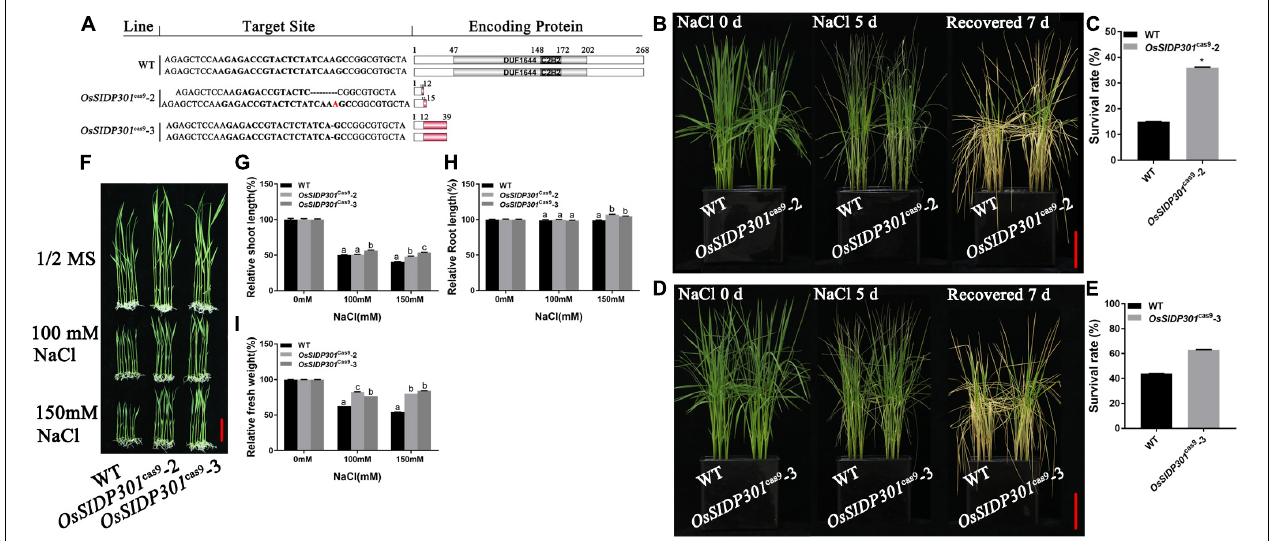
FIGURE 4 | Mutants of OsSIDP301 were conferred salt tolerance. (A) Mutation types of OsSIDP301 mutants. (B–E) Phenotype and survival rate of mutants were treated with containing 150 mM NaCl solution for 5 days and then recovered for 7 days, bar = 4 cm. (F) Phenotypes of mutants with NaCl treatment at the seedling stage, bar = 2 cm. Comparisons of shoot length (G) , root length (H) , fresh weight (I) between WT and mutants with or without NaCl treatment for 7 days. Data are shown as mean ± SD ( n = 8), different letters suggested significant difference at P <